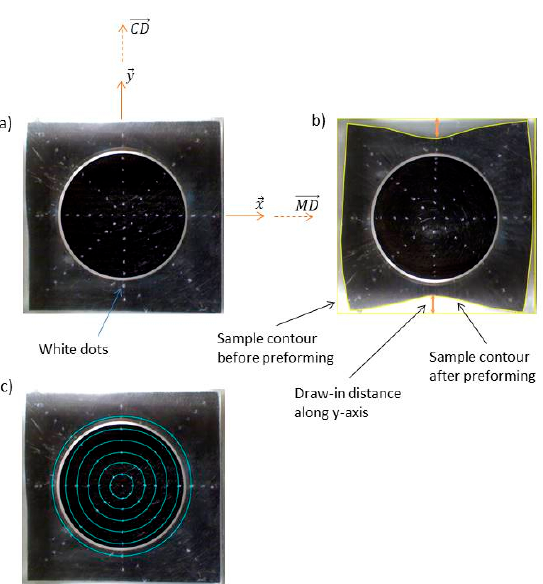
Figure 3. Specimen before preforming placed under blank-holder plate ( a ), formed preform under the blank-holder plate at the end of the punch course ( b ), and initial state of the concentric circles created from white dots marked on the specimen ( c ).